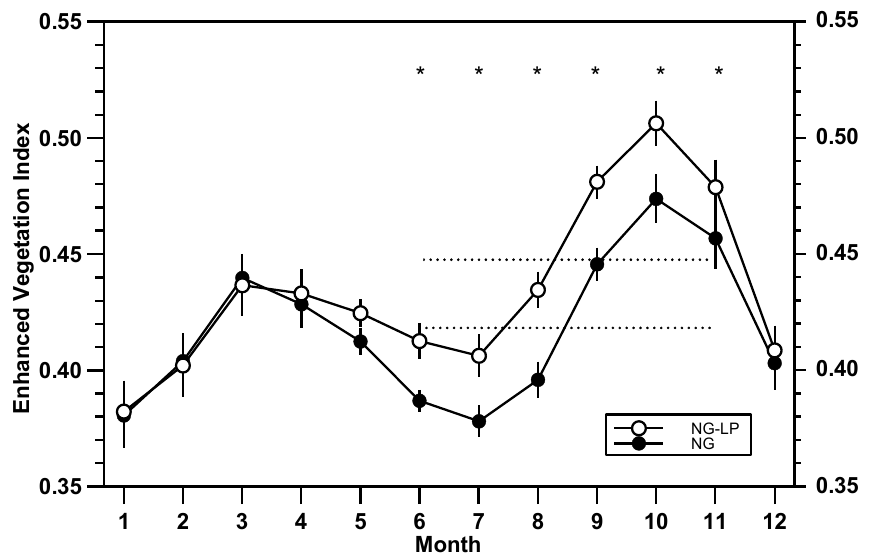
Figure 3. Mean Enhanced Vegetation Index (EVI) mean of natural grassland control (NG) and natural grassland overseed with legumes and fertilized with phosphorus (NG-LP), from January to December. Points corresponds to annual EVI mean of 20 paddocks (NG, n = 20; NG-LP, n = 20) during the nine years of the intensification practice. Error bars correspond to spatial standard error, horizontal dotted lines correspond to June to November mean value and asterisks above indicate months with significant differences between treatments (T ≥ 4.2, p value < 0.05).